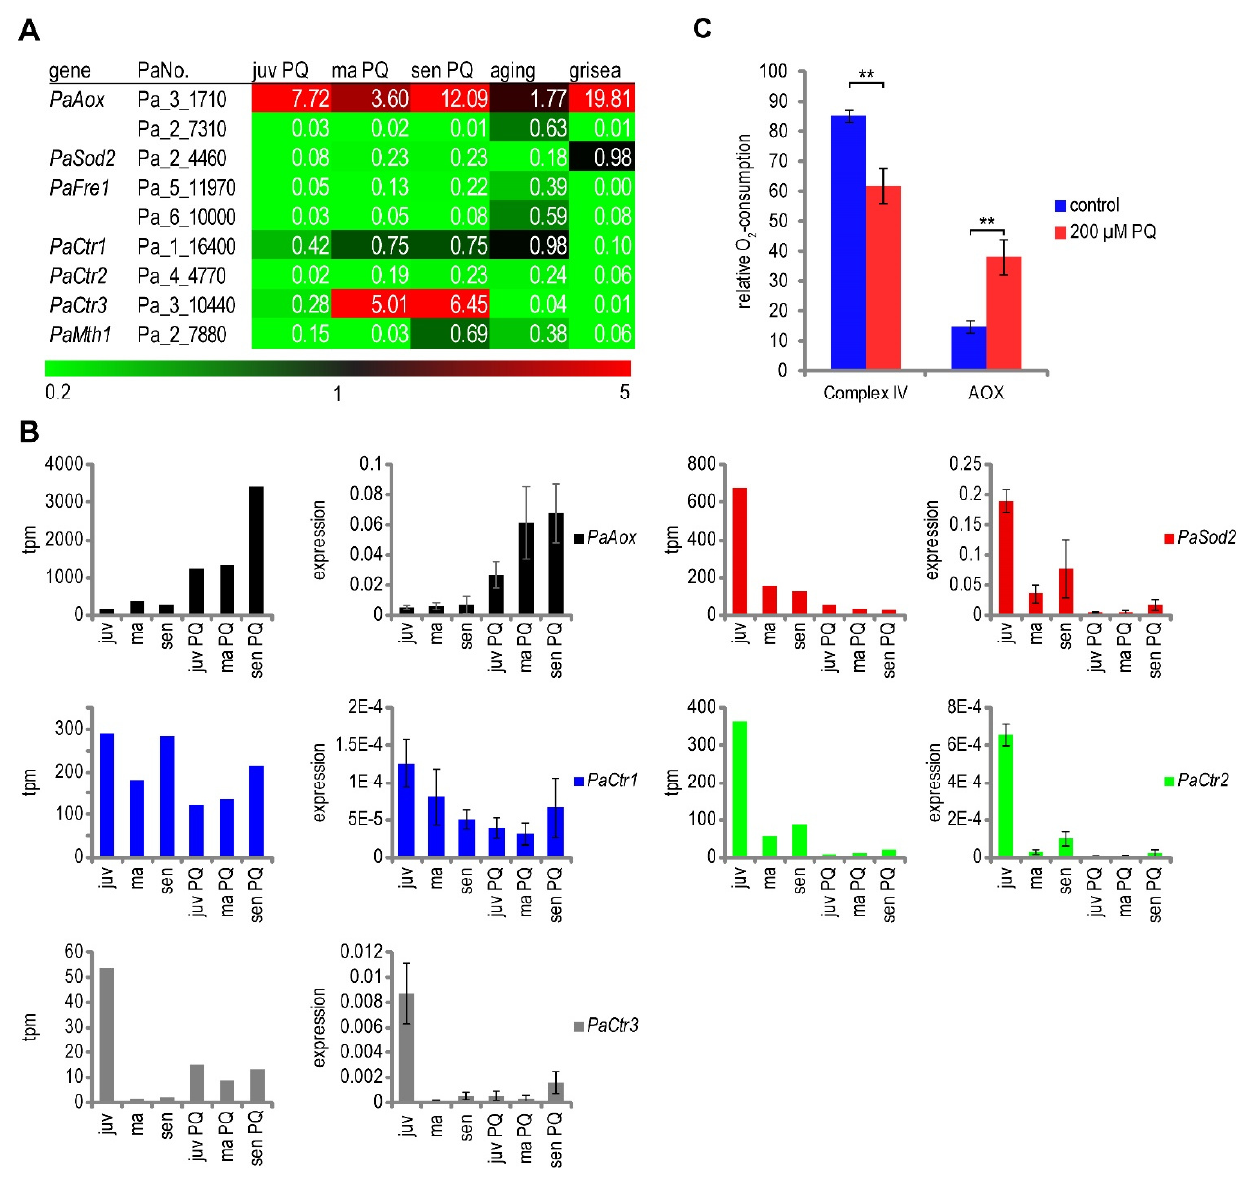
FIGURE 5: Effect of PQ-stress on the regulation of copper controlled genes. (A) Transcriptome data of copper and GRISEA regulated pro- teins. Colors and numbers indicate relative expression of transcripts of the indicated genes. Relative expression was calculated by dividing tpm of juvenile PQ-stressed samples by tpm of juvenile control (juv PQ), middle-aged PQ-stressed samples by middle-aged control (ma PQ), senescent PQ-stressed samples by senescent control (sen PQ), senescent control by juvenile control (aging) and grisea by wild-type control (grisea). (B) Verification of transcriptome data of the selected genes PaAox , PaSod2 , PaCtr1 , PaCtr2 , and PaCtr3 . Results from SuperSAGE analysis are shown in tpm (tags per million). The results of the corresponding qRT-PCR are depicted as relative expression levels to the refer- ence genes PaPorin and PaRpl19 . Data are displayed as mean ± standard error. n = 3. (C) Measurement of complex IV and PaAOX activity in control and PQ-stressed mycelia. Juvenile P. anserina was grown as described for transcriptome analysis. The oxygen consumption of 2 to 9 mg mycelium was measured in a high resolution respirometer. To determine the percentage of complex IV and PaAOX dependent respira- tion, a final concentration of 4 mM SHAM and 1 mM KCN was used to inhibit PaAOX and complex IV, respectively. Bars are mean ± standard error of 6 - 7 experiments with two different cultures. n = 20. Student’s t-test: pV =